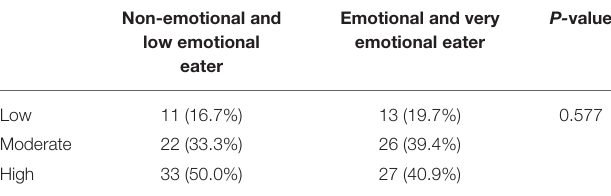
TABLE 6 | Association between psychological factors affecting eating habits and MET categories among government servants during